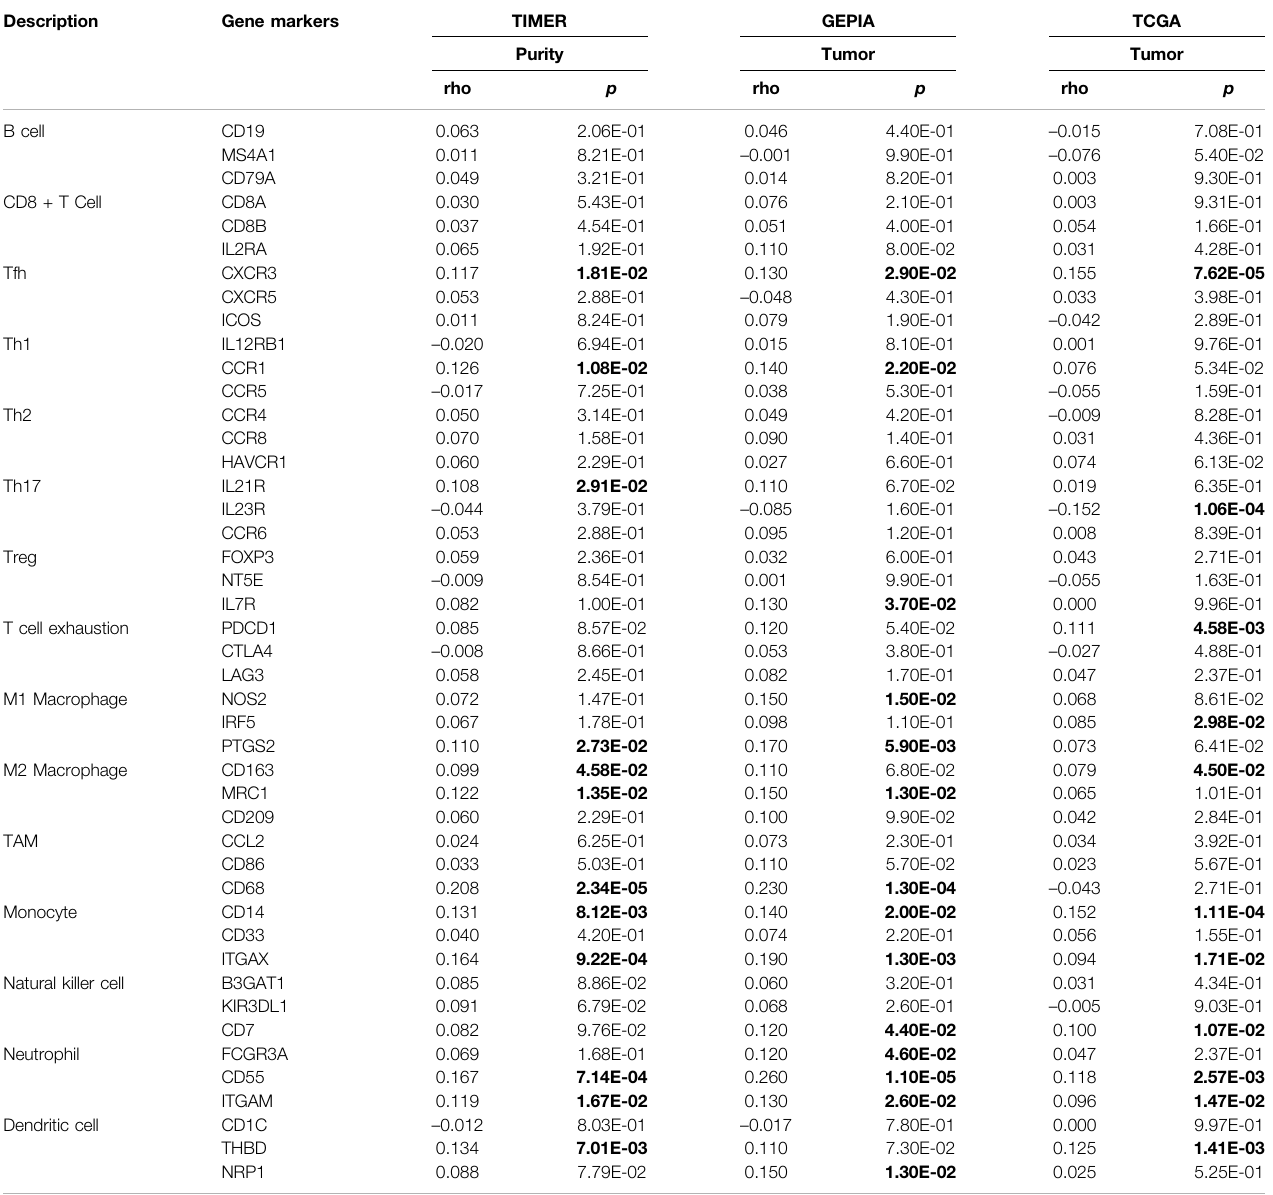
Bold values indicate p <